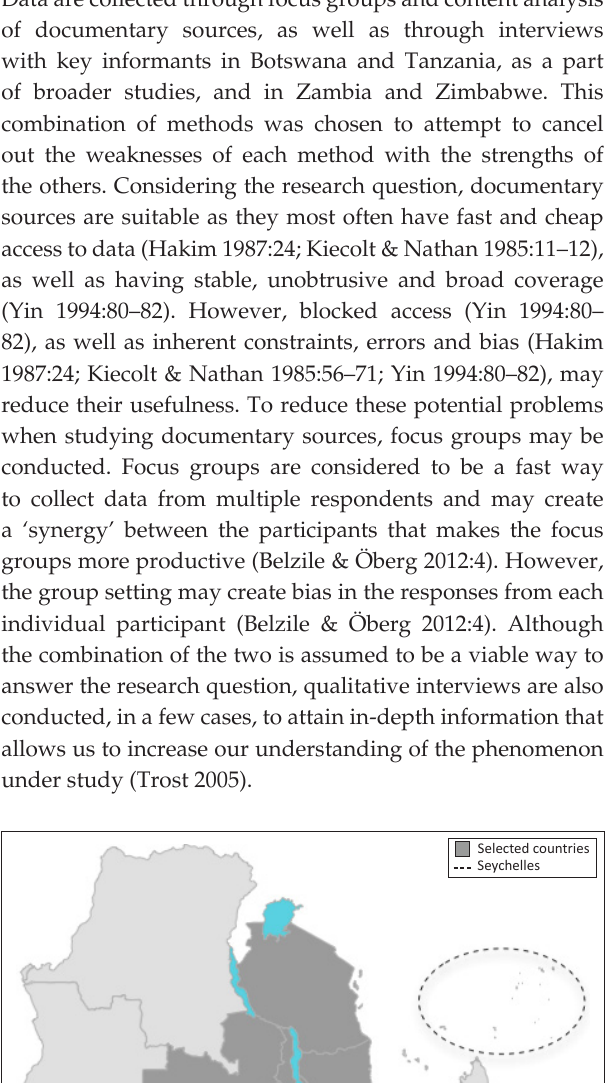
Selected countries